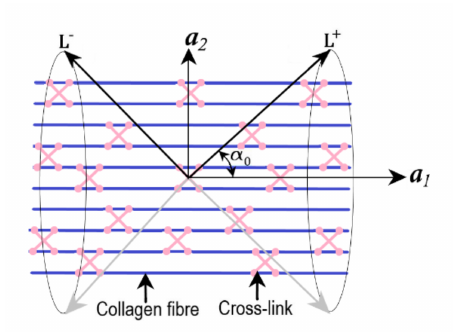
Figure 6. Collagen fibre with the cross-links structure proposed by Holzapfel and Ogden [87] (Reprinted from ref.